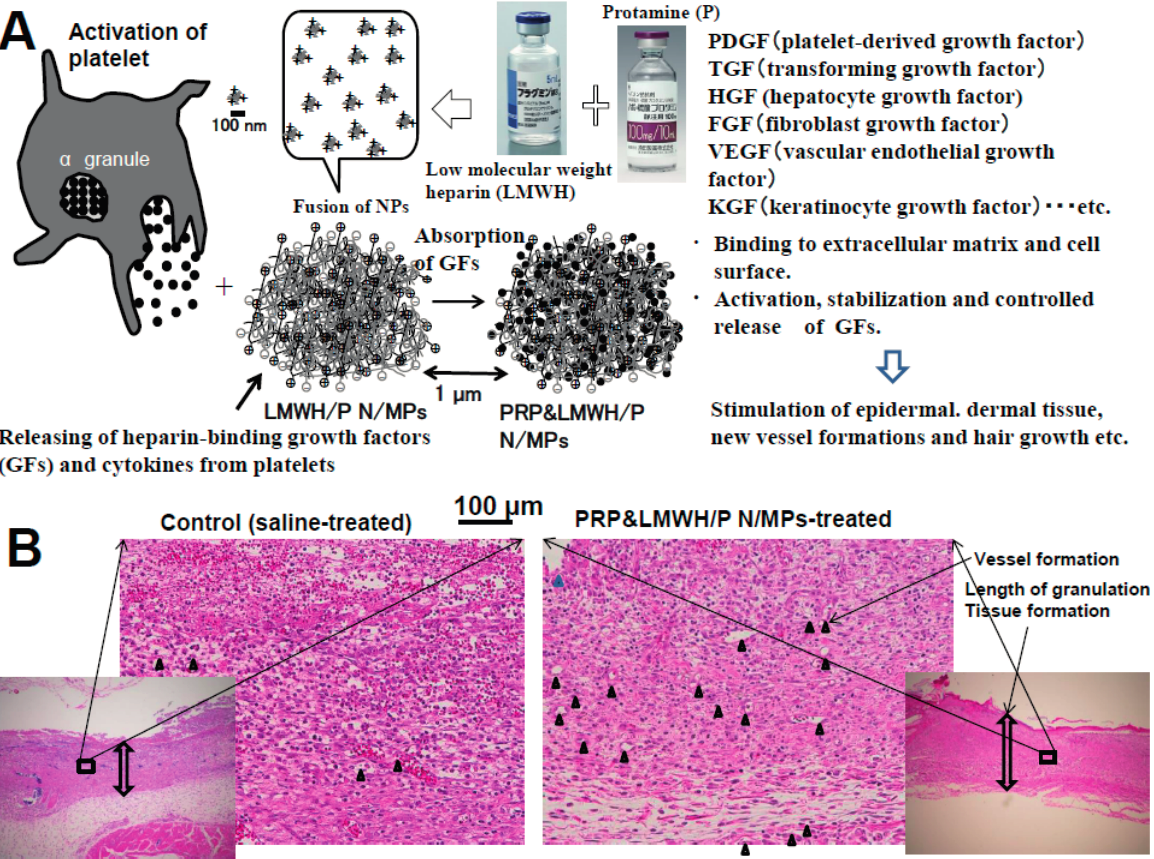
Figure 3. ( A ) Growth factors (GFs) from platelet-rich plasma (PRP) and LMWH/P N/MPs significantly induce neovascularization and granulation tissue formations. ( B ) Histological examinations of the base of wounds treated with saline (control), GFs from PRP and LMWH/P N/MPs-treated skin. Each photograph for wounds on day 7 was representative of eight rats. The vertical arrows show the length of formed granulation tissue, and black triangles show generated small blood